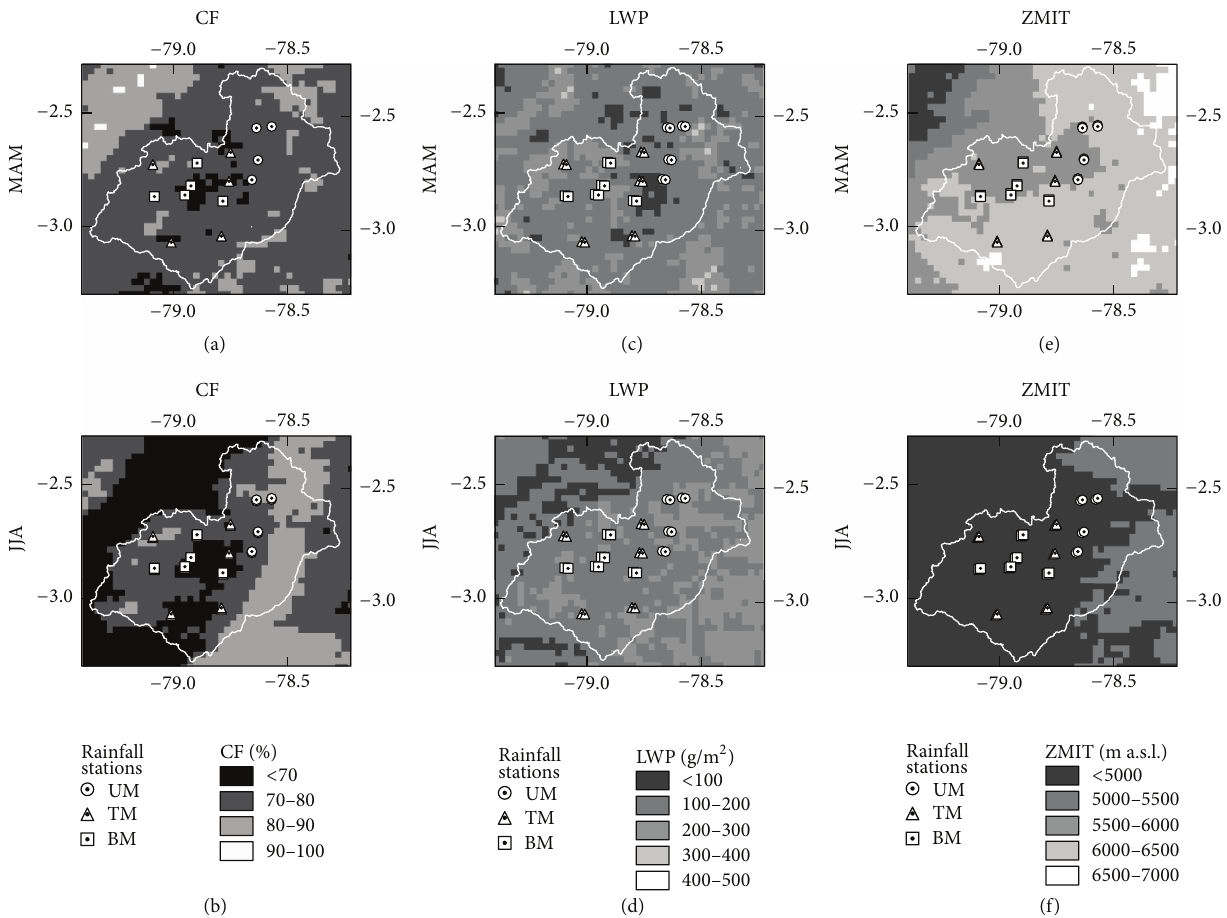
Figure 6: Seasonal average for CF, LWP, and ZMIT (left, centre, and right columns) during MAM and JJA seasons (top and bottom rows).